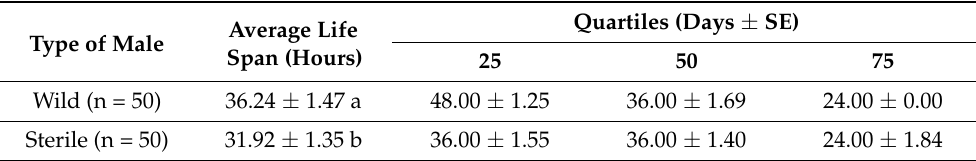
Table 4. Response (time to death) of wild and sterilized Aedes albopictus males under food and water starvation.